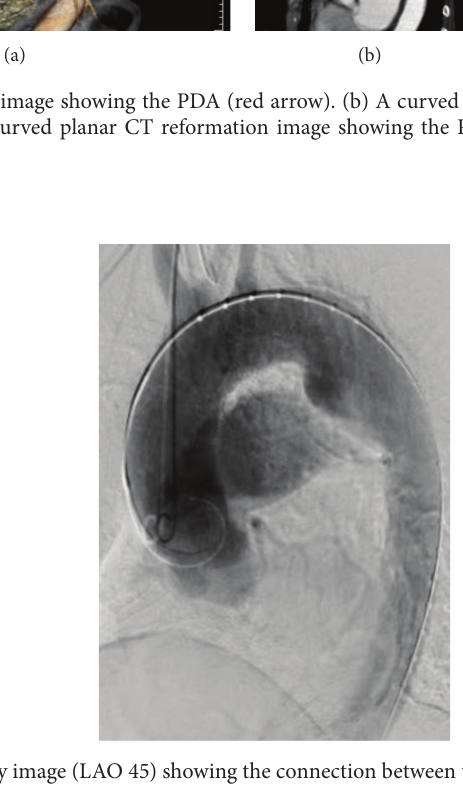
Figure 2: An aortography image (LAO 45) showing the connection between the TAA and the pulmonary artery.